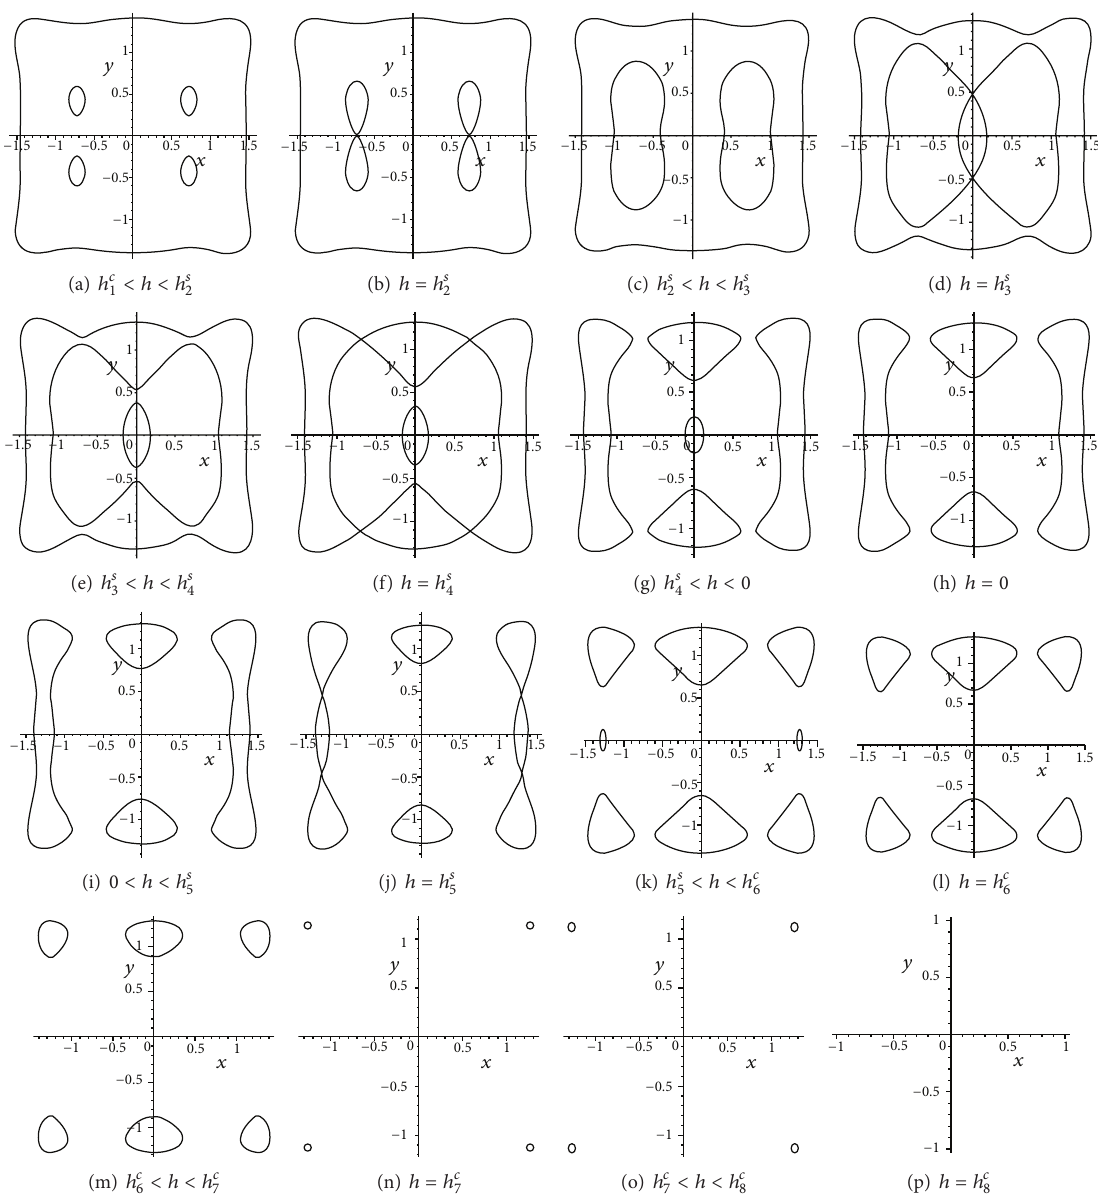
Figure 3: Different schemes of ovals defined by ((11a) and (11b)) as ℎ varied with UP are given.